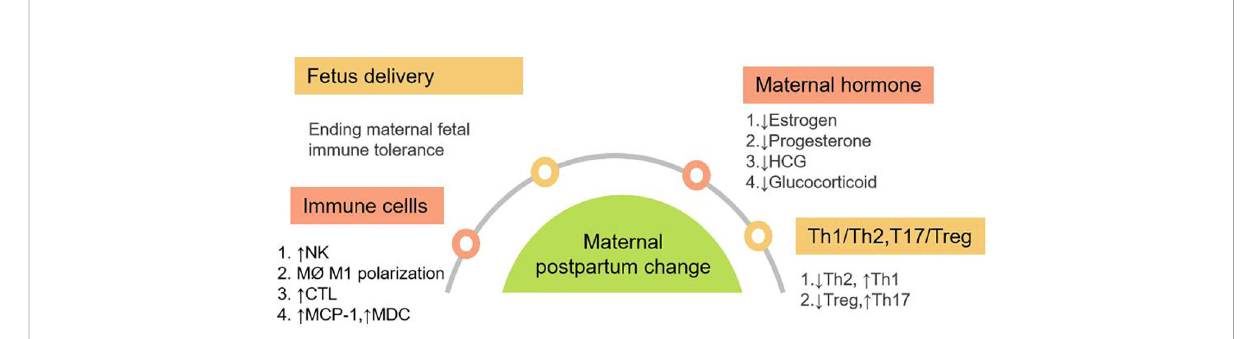
FIGURE 3 Maternal Postpartum changes in immune system and hormone. It mainly includes four aspects: Fetal delivery; changes of immune cells; changes in maternal hormone levels; changes of Th1, Th2, Th17 and Treg balance in vivo . Abbreviation: MCP-1: monocyte chemoattractant protein-1, MDC:macrophage derived